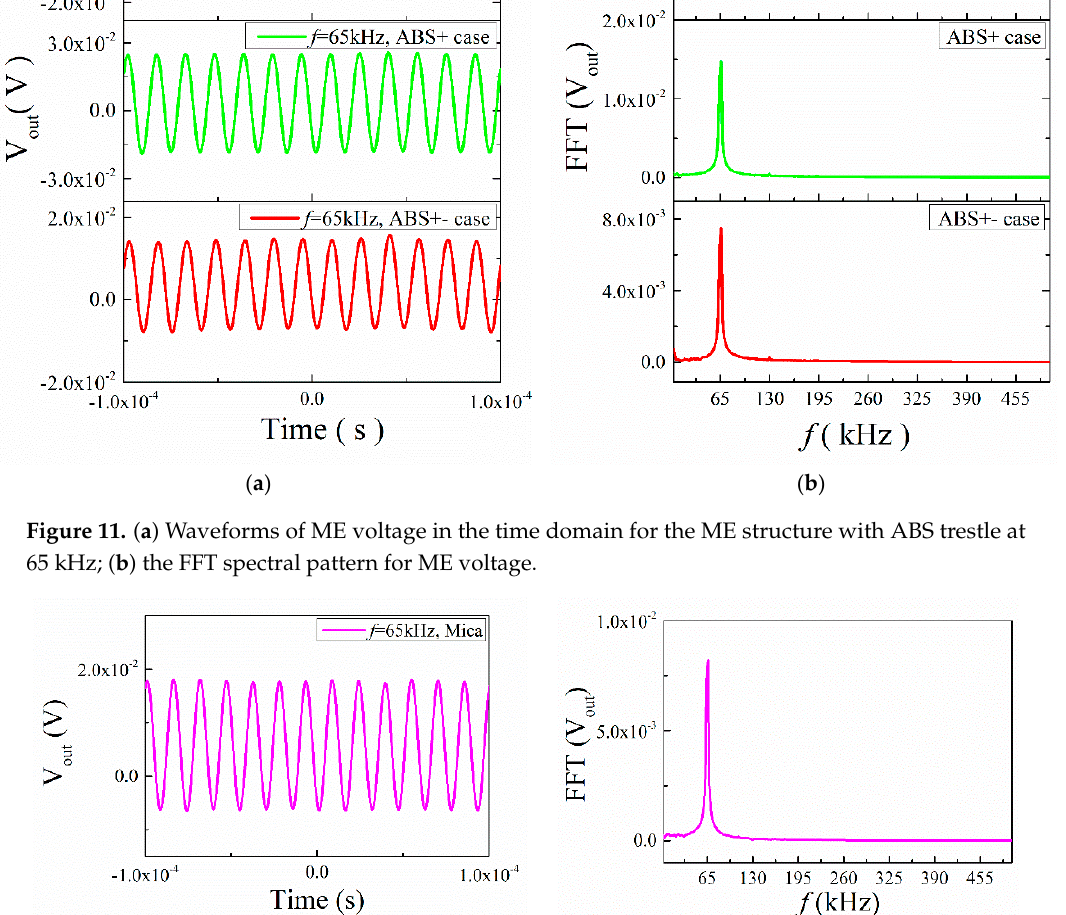
Figure 13. ( a , c , e , g ): Waveforms of ME voltage in the time domain for the ME structure at the higher resonance frequency; ( b , d , f , h ): the FFT spectral pattern for ME voltage.